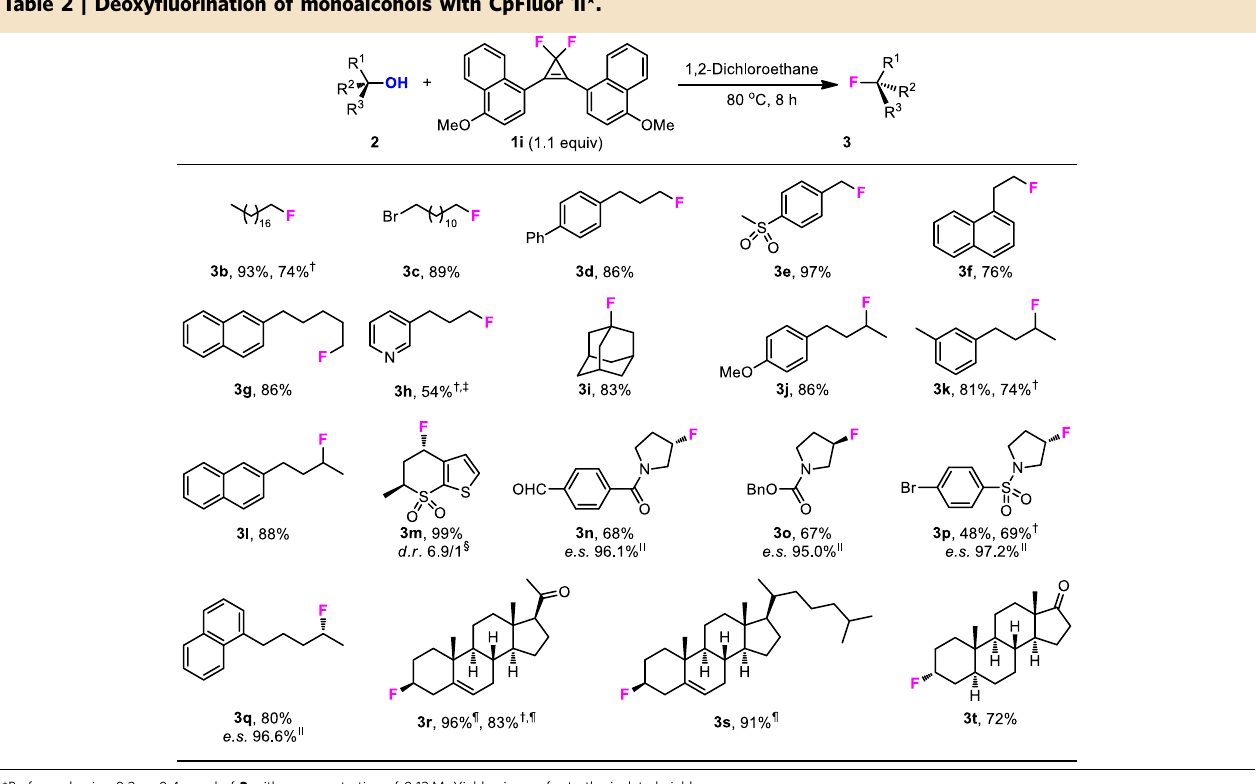
Table 2 | Deoxyfluorination of monoalcohols with CpFluor